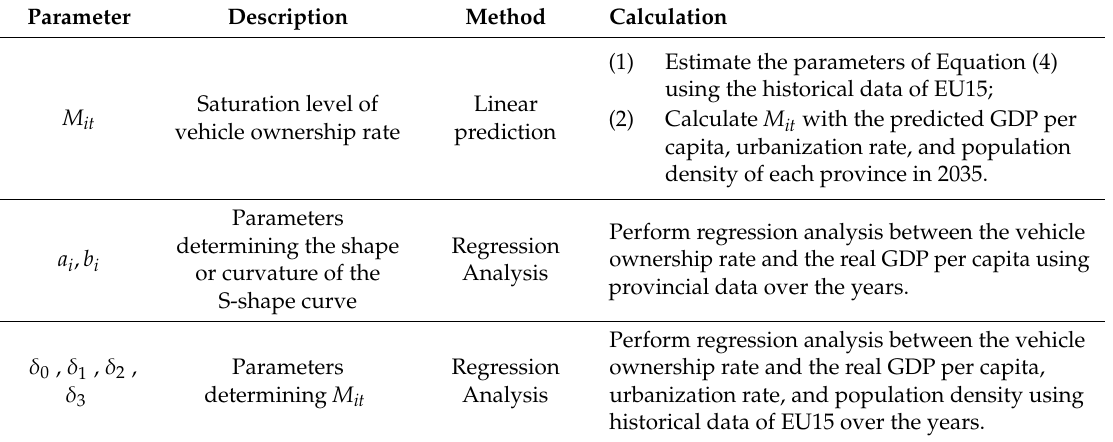
Table 1. Descriptions of model